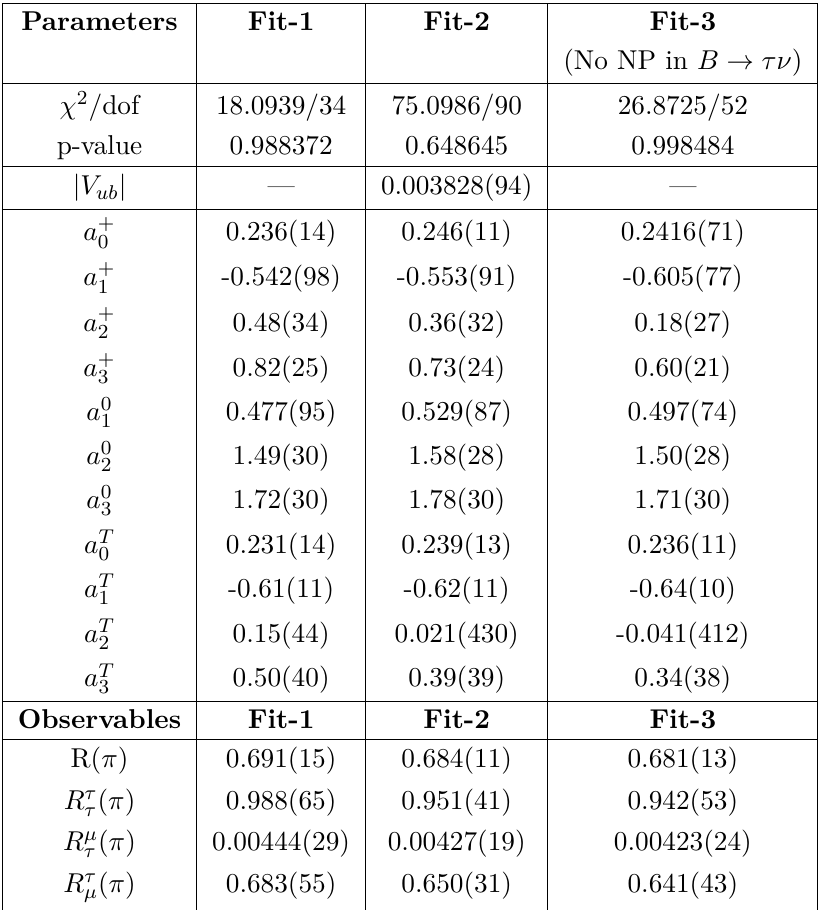
Table 1. Fit results for the coefficients of the form factors a i contribute to semileptonic B → π transitions using a BSZ parametrization as mentioned in the text. The kinematic constraint f + (0) = f 0 (0) is manifest in such a parametrization simply implying that a + = a 0 and hence a 0 has not been explicitly shown in the table. Note that the a T 0 0 0 take part in semileptonic charged current B → π transitions within the SM and hence are simply constrained by the LCSR and Lattice